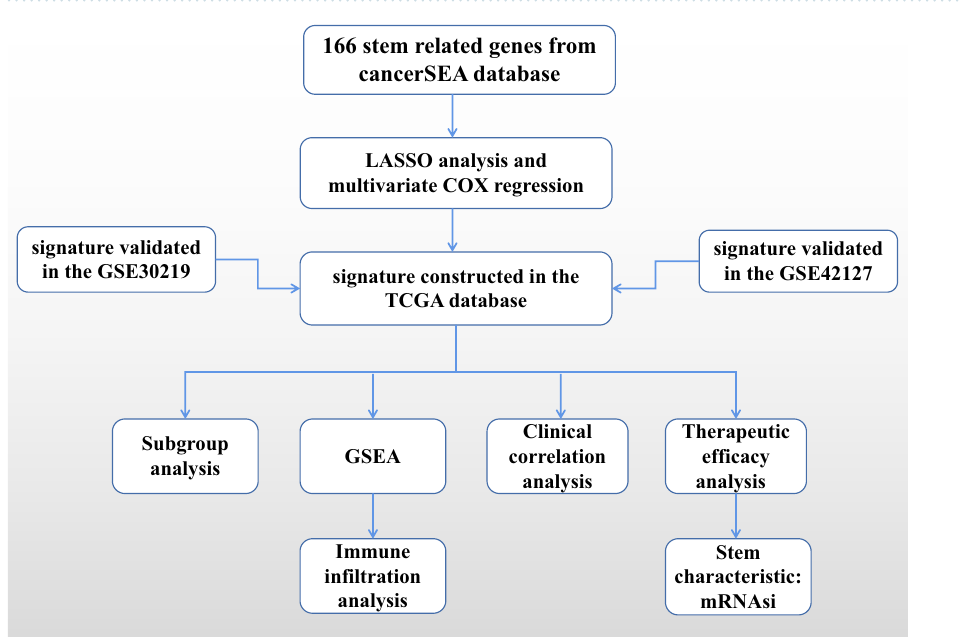
Figure 9. Flow chart. The flow chart was drawn to show the thought and process of our